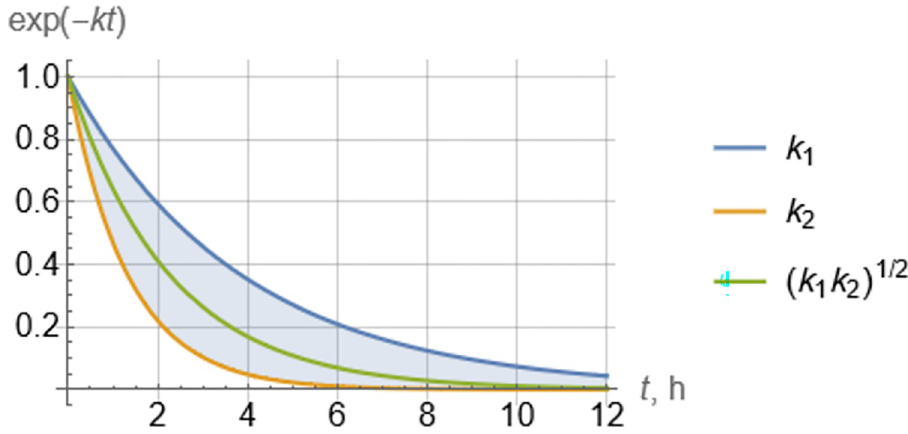
Fig 10. Exponential peak-to-peak decline rate modes corresponding to each individual rate k 1 , k 2 (Eq (18)) and the geometric average rate k ≝ ( k 1 k 2 ) 1/2 (Eq (9)).